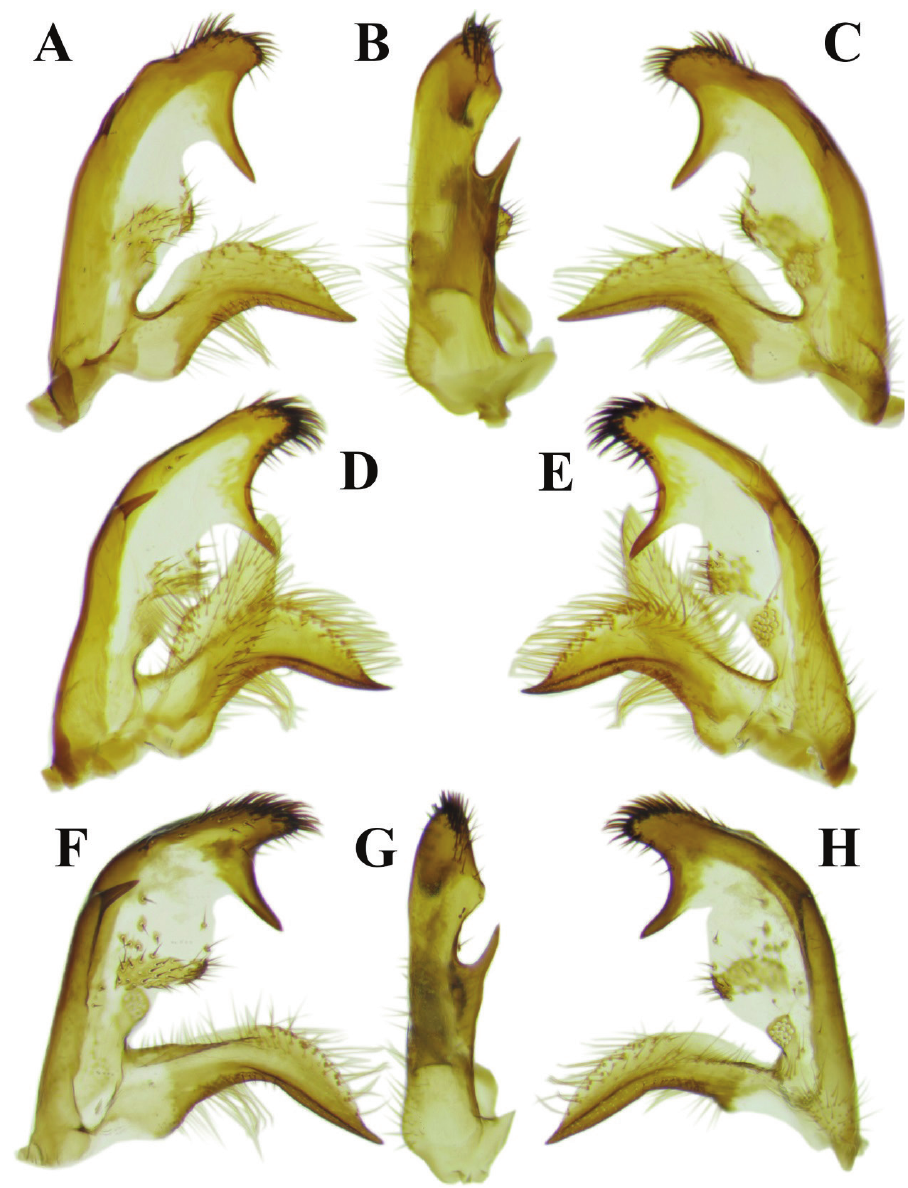
Figure 6. Photographs of the morphological structures of the male genital structures of individuals of Tipula ( Mediotipula ) stigmatella Schummel, 1833. Specimen from Kavala (Greece) A, B, C Specimen from Lunca Bradului (Romania) D, E ; Specimen form Kulata (Bulgaria) ( F, G, H ) A, F inner gonostylus outer lateral view B, G inner gonostylus ventral view C, H inner gonostylus inner lateral view D gonostyli outer lateral view E gonostyli inner lateral